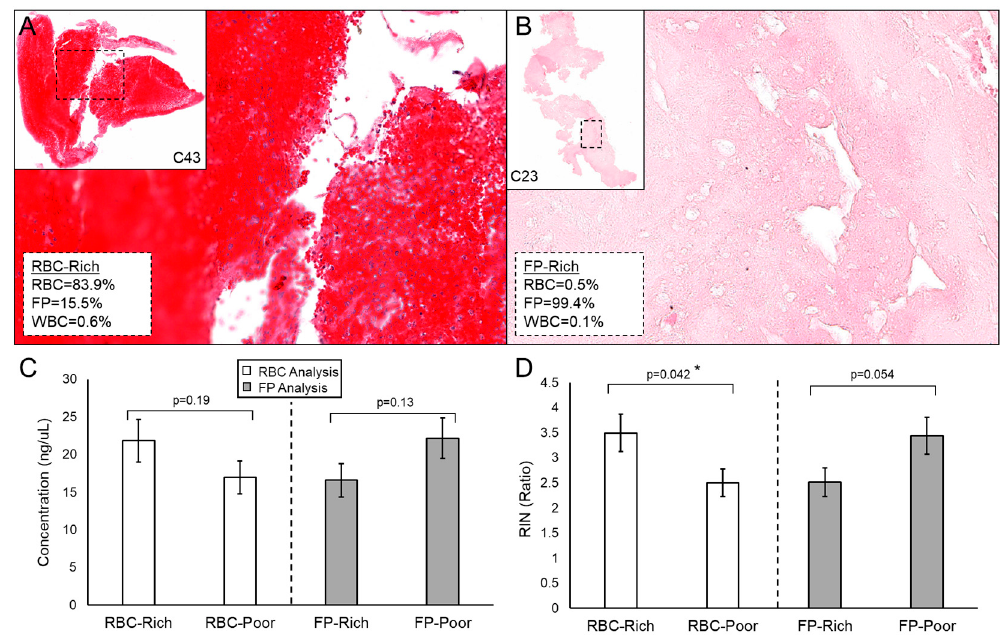
Figure 3. Histologic analysis of clots. ( A ) An example of an RBC-rich clot. ( B ) An example of an FP-rich clot that is largely acellular. ( C ) Average concentration in RBC-rich ( ≥ 50%) vs. RBC-poor (<50%) clots, and FP-rich ( ≥ 50%) vs. FP-poor (<50%) clots. ( D ) Average RIN in RBC-rich vs. RBC-poor clots and FP-rich vs. FP-poor. Error bars represent standard error, and “*” indicates statistical significance, p < 0.05 from Student’s t -test. (Abbreviations: FP = fibrin/platelet; RBC = red blood cell; RIN = RNA integrity number; WBC = white blood cell).